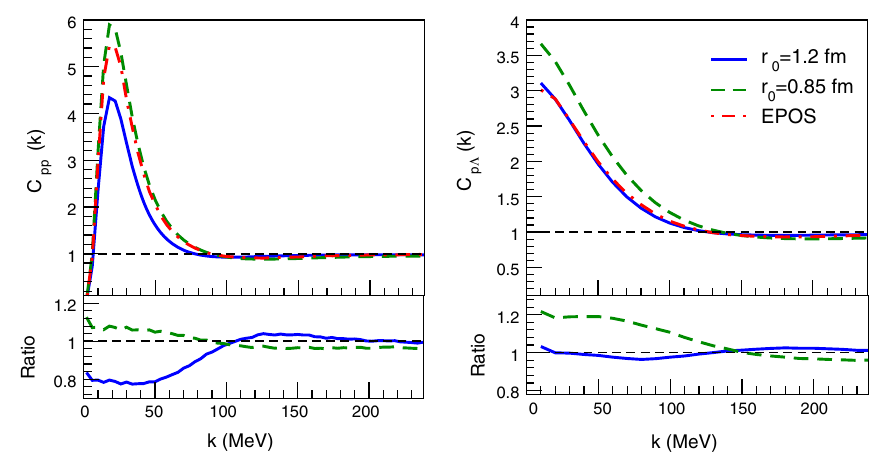
Fig. 7 Correlation functions for p–p pairs (left) with Av 18 potential and p– (cid:2) pairs (right) with χ EFT NLO potential (see 2.2). The calculations are performed by assuming Gaussian emitting sources of radii r 0 = 1 . 2 fm (solid blue line), r 0 = 0 . 85 fm (dashed green line) and by using EPOS transport model (red dot-dashed